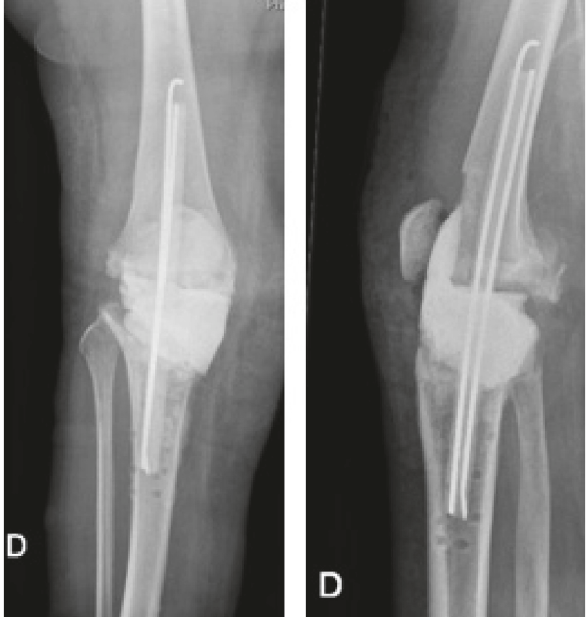
Figure 12: X-rays showing 2 years postoperatively rotating hinge total knee replacement with metal